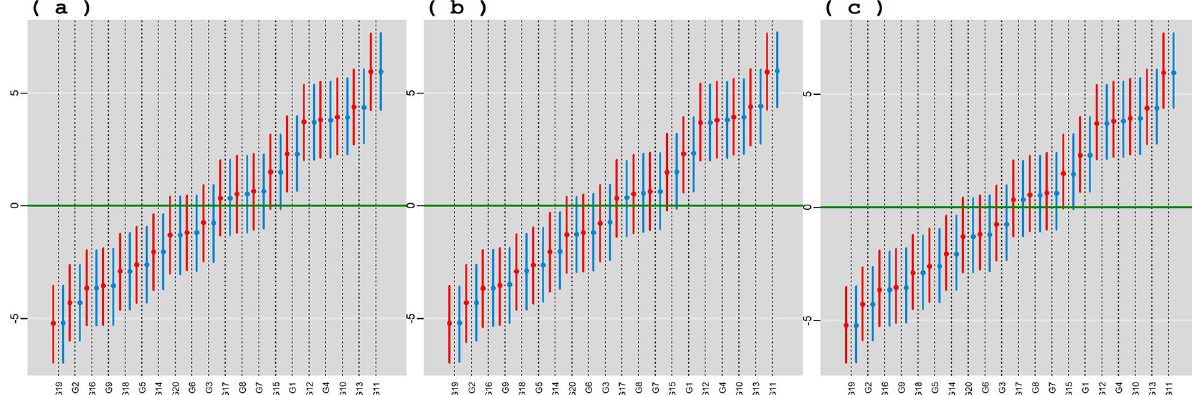
Fig 3. Posterior means and the 95% HPD intervals for the effect of genotypes, conditional response (blue color) and marginal responses (red color) referring to: a) BAMMI-3; b) BAMMIS-3; c)